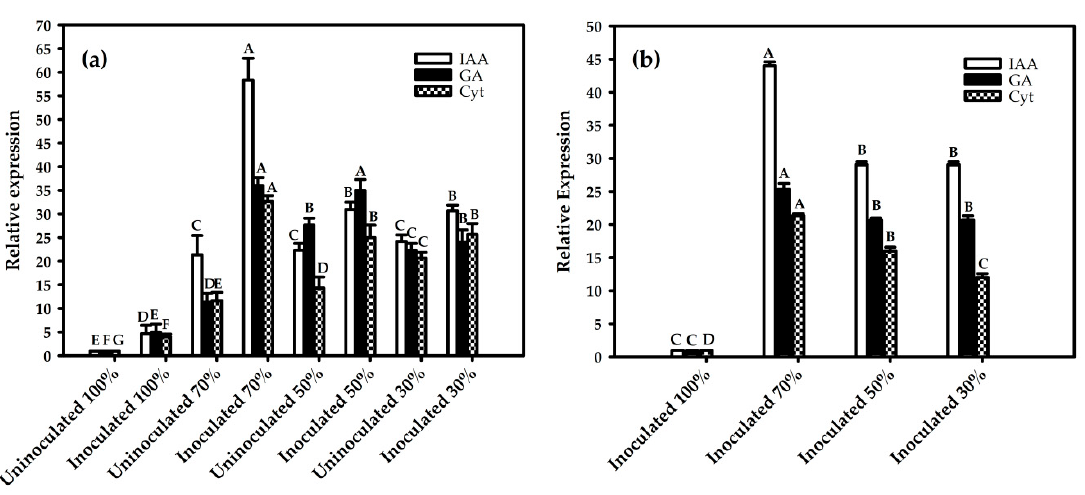
Figure 5. RT-qPCR analysis of phytohormone key genes during drought stress. ( a ) Red rice genes and ( b ) G. diazotrophicus genes. Averages followed by identical capital letters do not differ in the inoculation condition for each soil water treatment. Bars represent the standard error (n = 3).